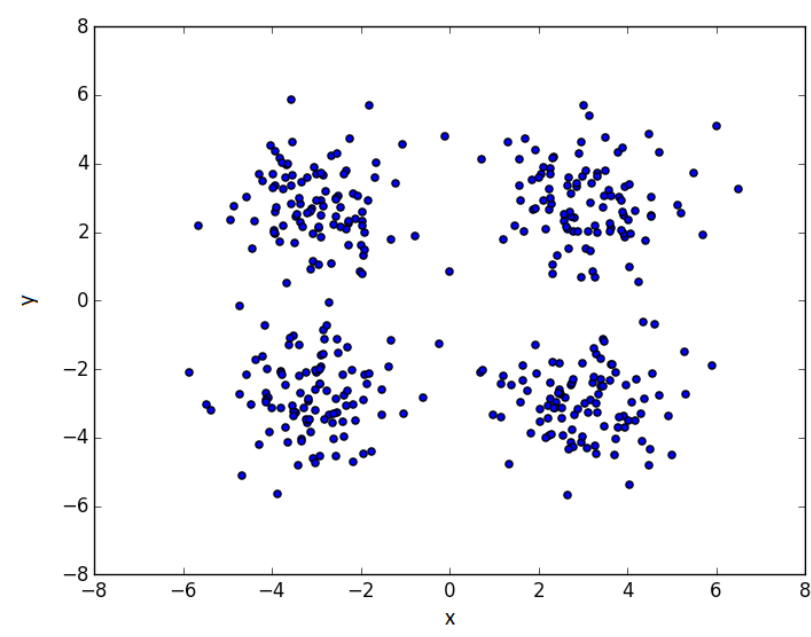
Figure 2. Sample clusters of 100 points